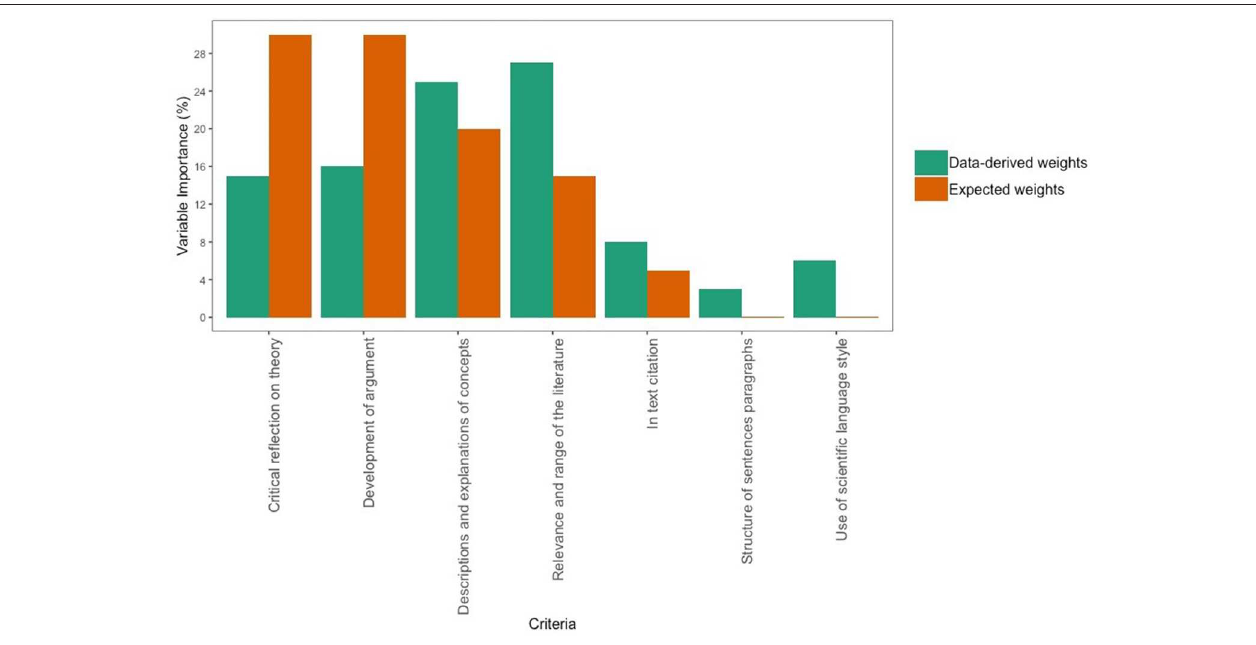
FIGURE 7 | Year 3 Essay questions (exams): data-derived and expected